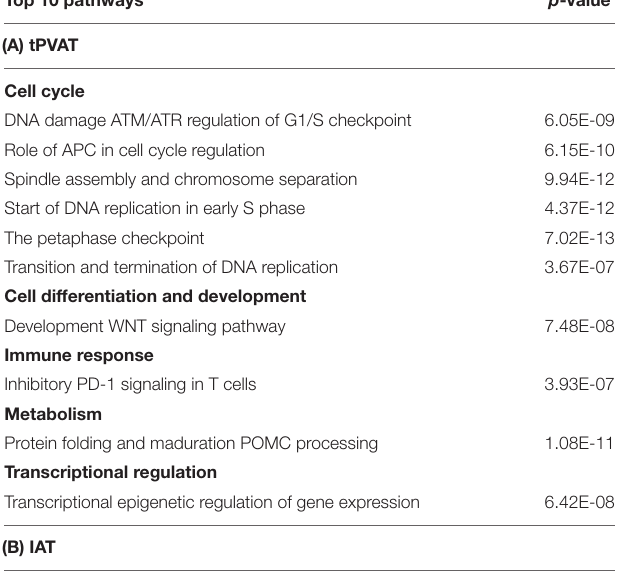
TABLE 3 | Top 10 regulated pathways analyzed by MetaCoreTM in the tPVAT (A) and IAT (B) . Top 10